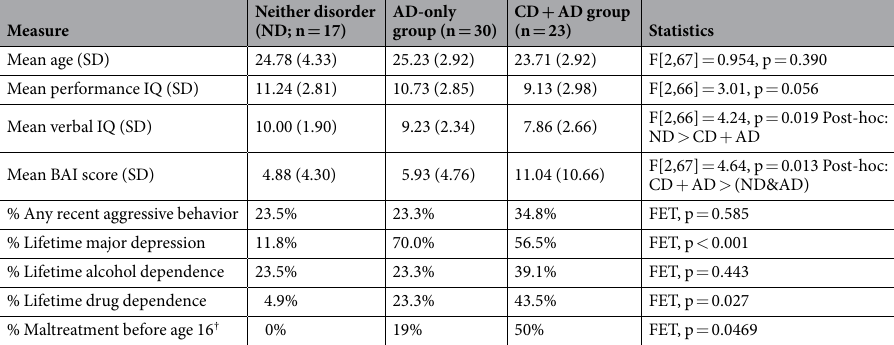
Table 1. Sample characteristics. FET: Fisher’s exact test. † Maltreatment data omitted case-wise for n = 3 in AD- only and n = 5 in CD + AD group due to being inconclusive as to what age maltreatment